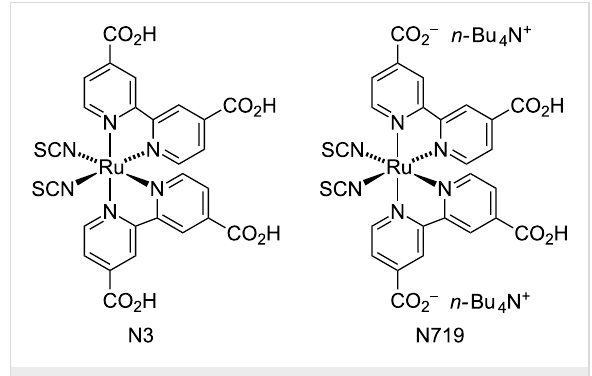
Scheme 1: Structures of the ruthenium dyes N3 and